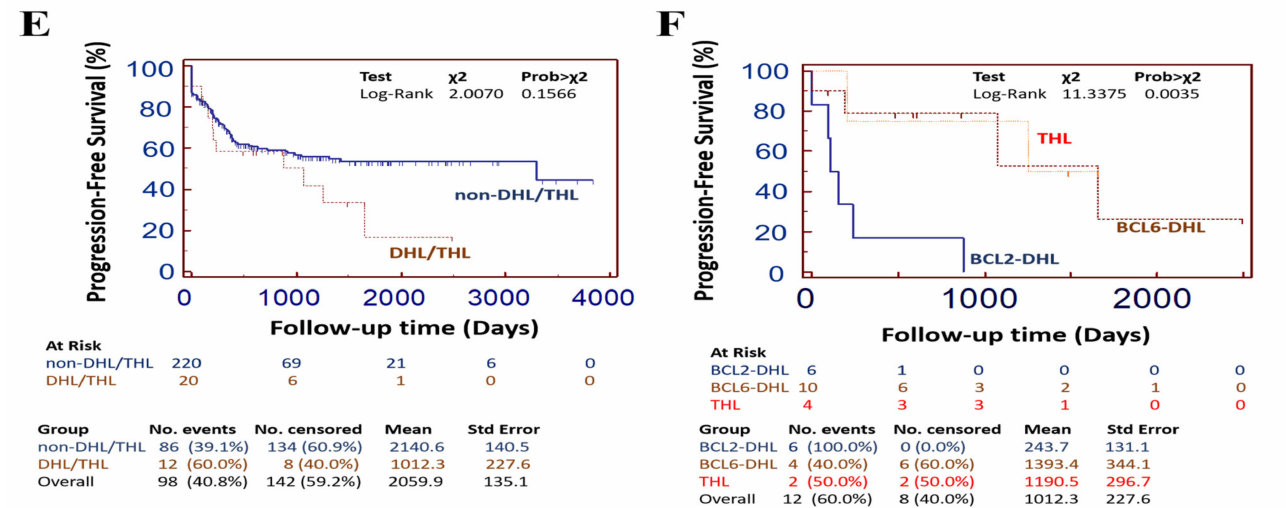
Figure 4. Multiple hits (DHL/THL) confer poor prognosis. Kaplan-Meier curves showing the differential effect of ( A ) DHL/THL or non-DHL/THL, and ( B ) BCL2-DHL, BCL6-DHL or THL on the overall survival of our DLBCL cohort ( n = 282). Kaplan-Meier curves showing the age-adjusted differential effect of DHL/THL or non-DHL/THL on the overall survival of our DLBCL cohort ( n = 282) in patients ( C ) younger than, or ( D ) older than 60 years. Kaplan-Meier curves showing the differential effect of ( E ) DHL/THL or non-DHL/THL, and ( F ) BCL2-DHL, BCL6-DHL or THL on the Progression-free survival of our DLBCL cohort ( n = 282). DHL, double hit lymphoma; THL, triple hit lymphoma; X 2 ,